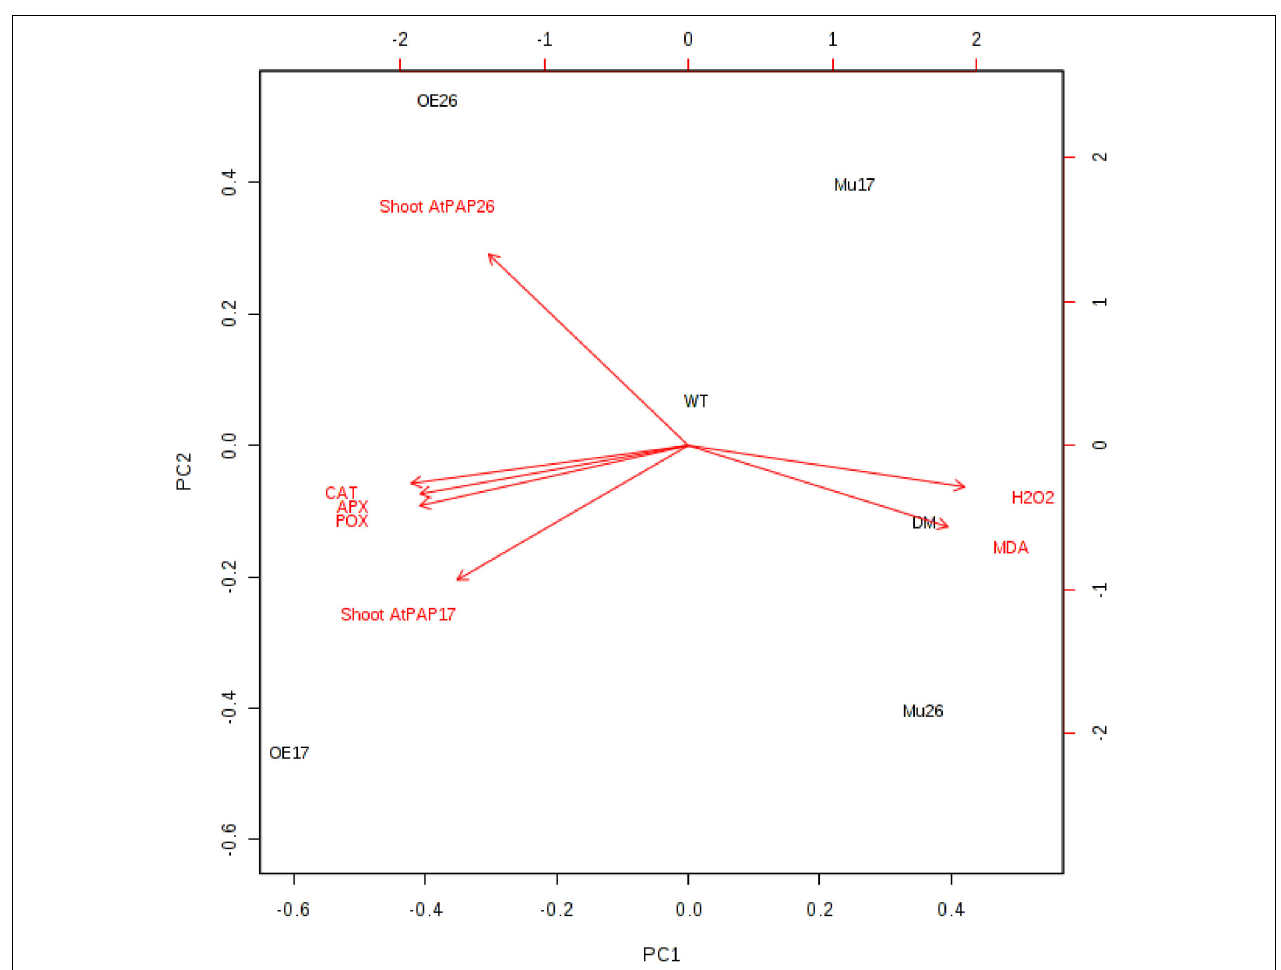
FIGURE 7 | Biplot analysis of the expression level of ATPAP17 and AtPAP26 genes in shoot; catalase (CAT), guaiacol peroxidase (POX), and ascorbate peroxidase activities (APX); H 2 O 2 and MAD accumulation in the examined genotypes to show the relationship at 150 mM NaCl stress. Wild type (WT), overexpress (OE), single mutant (Mu), and double mutant (DM) genotypes of Arabidopsis thaliana purple acid phosphatase 17 ( AtPAP17 ) and 26 ( AtPAP26 )